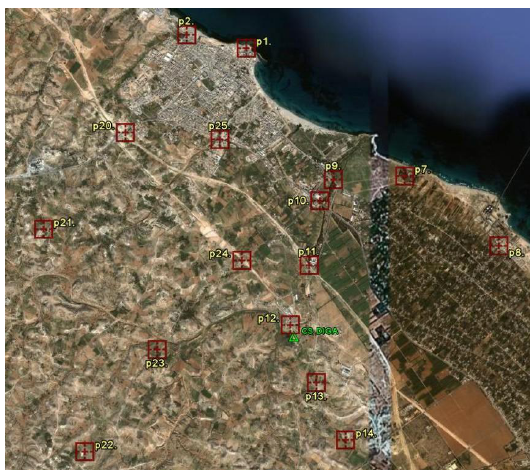
Figure 8. Support points for satellite images